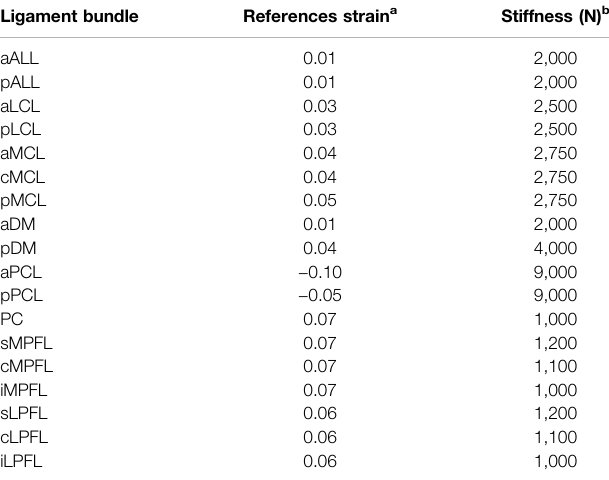
TABLE 1 | Reference strain and stiffness of the ligament bundles used in the musculoskeletal model (Blankevoort et al., 1991; Marra et al., 2015). Ligament